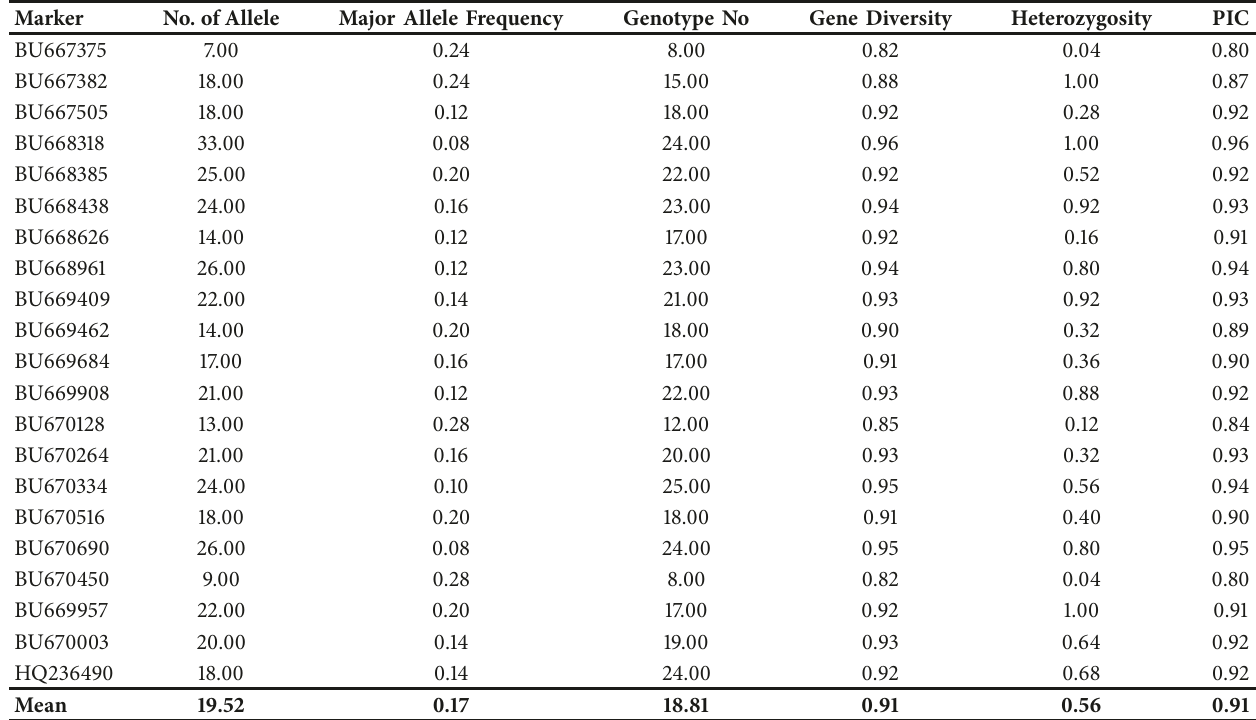
Table 4: Summary statistics of genetic variation among sesame accessions using SSR markers.